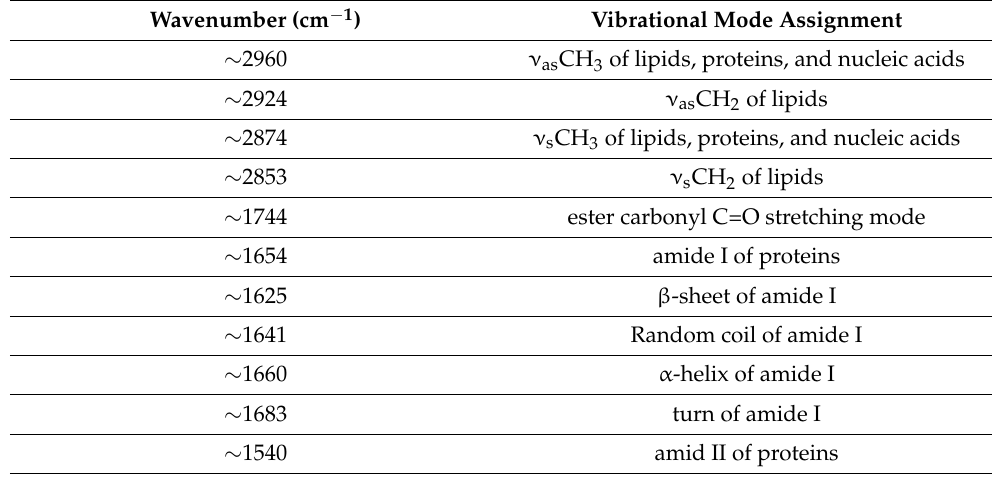
a ν = stretching vibrations, s = symmetric vibrations, and as = asymmetric vibrations.